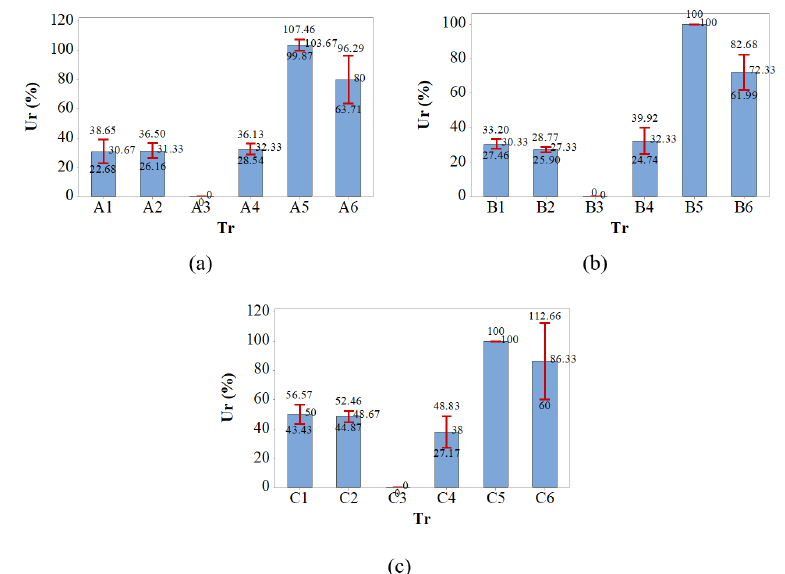
- %) referring to the six experimental treatments per block type - 14×19×29cm (a), Figure 4. Relative humidity results ( r U 19×19×39cm (b) and 14×19×39cm